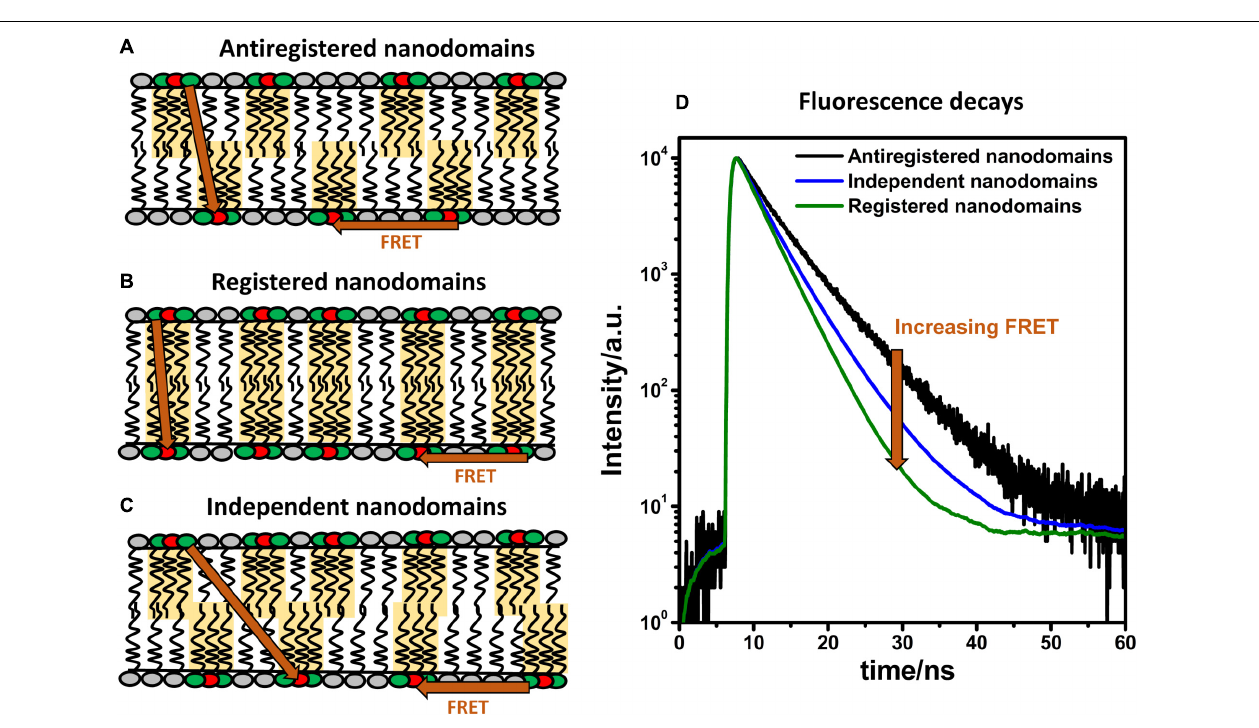
FIGURE 5 | FRET and domain registration. In a lipid bilayer, FRET (indicated by orange arrows) occurs within the same leaflet (intra-FRET) but also from one leaflet to the other one (inter-FRET). The efficiency of FRET, measured by time-resolved spectroscopy, depends on mutual organization of nanodomains. The efficiency of FRET is the lowest when nanodomains are in antiregistration (A) , intermediate when they are independent (B) , and the highest when the nanodomains are registered (C) . Time-resolved fluorescence decays of donors in the presence of acceptors shown on panel (D) report on the kinetics of deexcitation and contain information about the size and concentration of nanodomains and their interleaflet